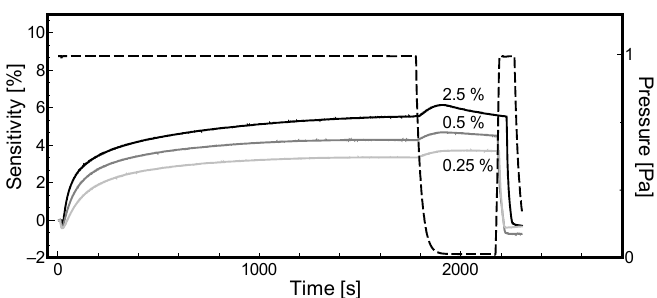
Figure 4. Effect of sensitivity of Sample 213-2 on hydrogen concentrations.